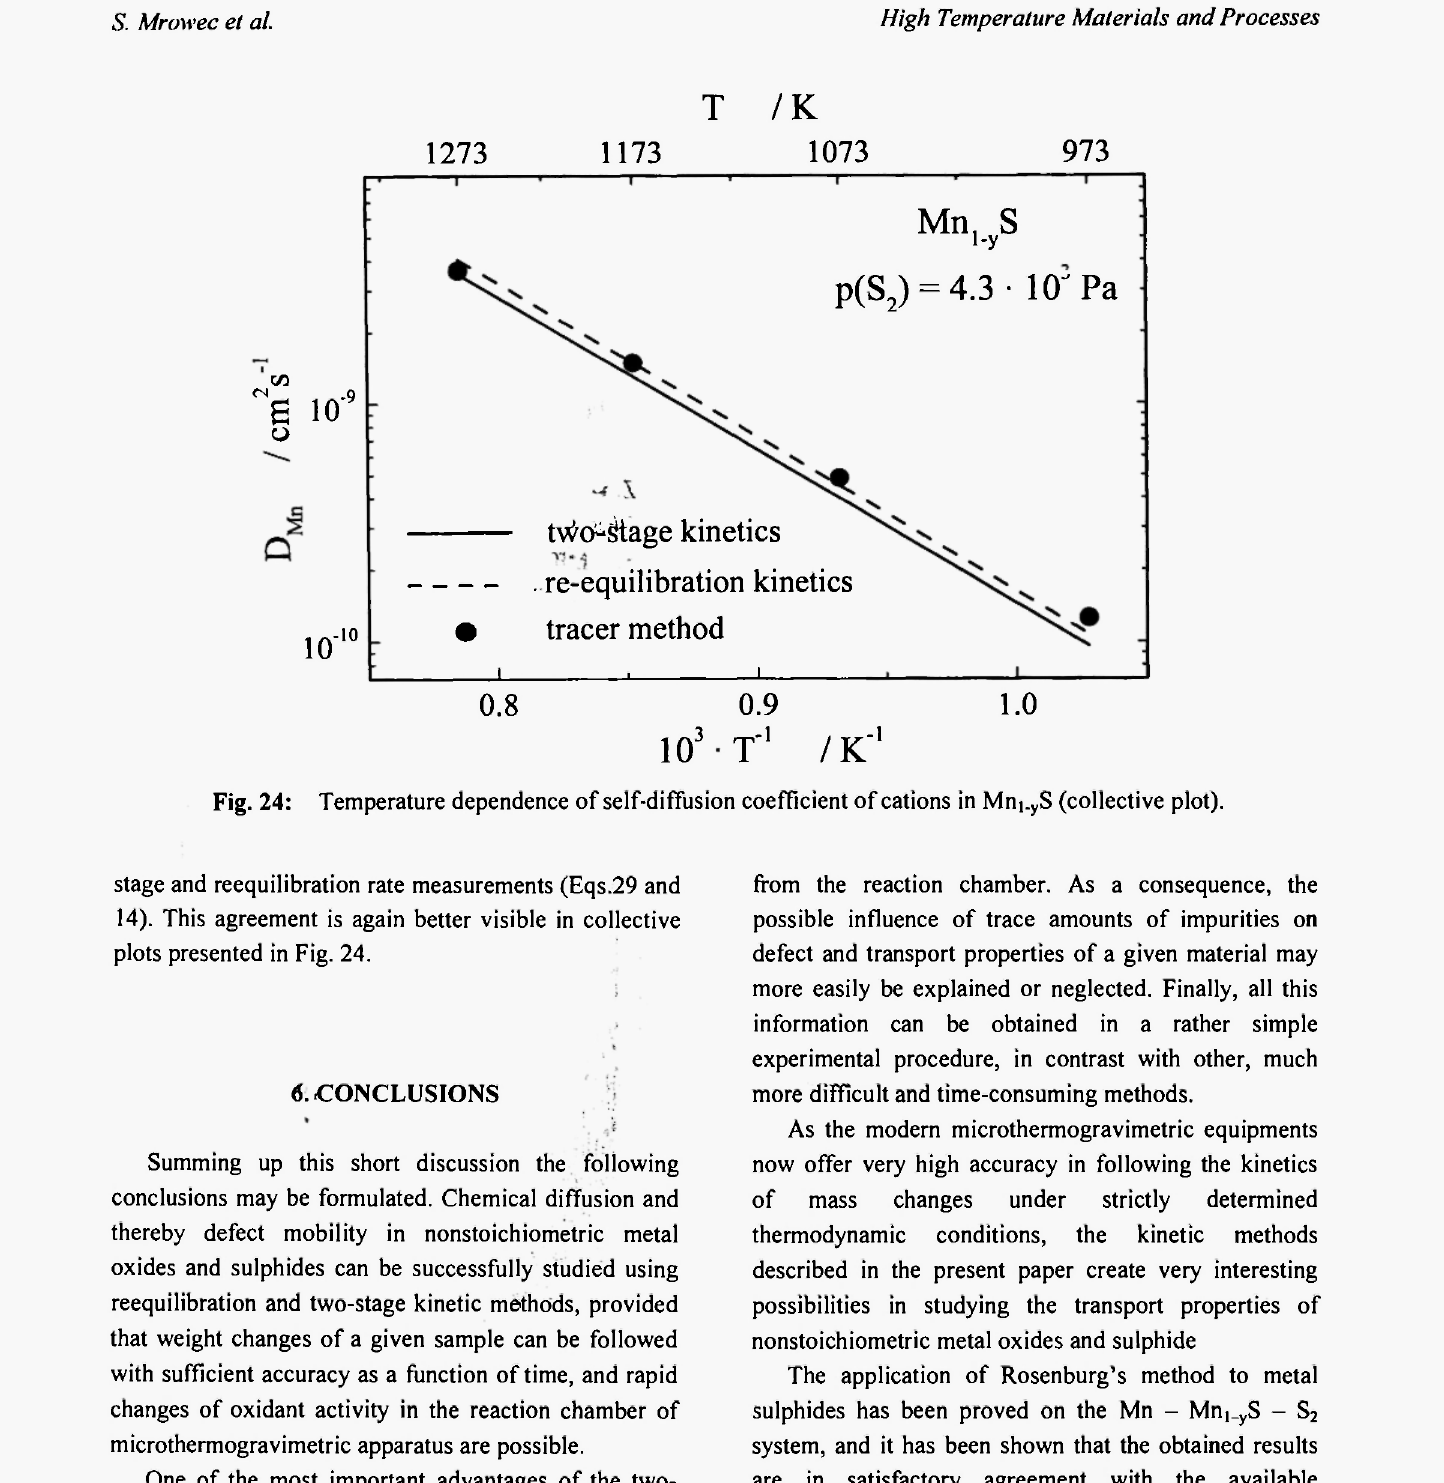
stage and reequilibration rate measurements (Eqs.29